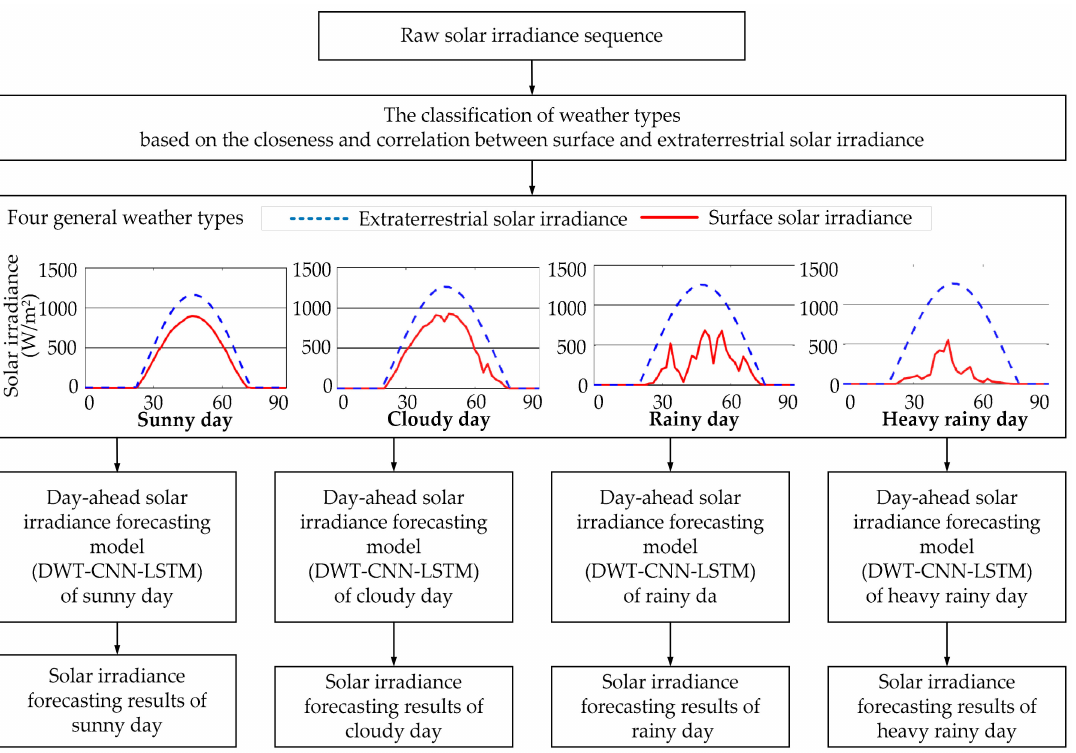
Figure 1. The flowchart of the day–ahead solar irradiance forecasting for four general weather types. The DWT-CNN-LSTM forecasting model is based on discrete wavelet transformation (DWT), convolutional neural network (CNN) and long short term memory (LSTM)